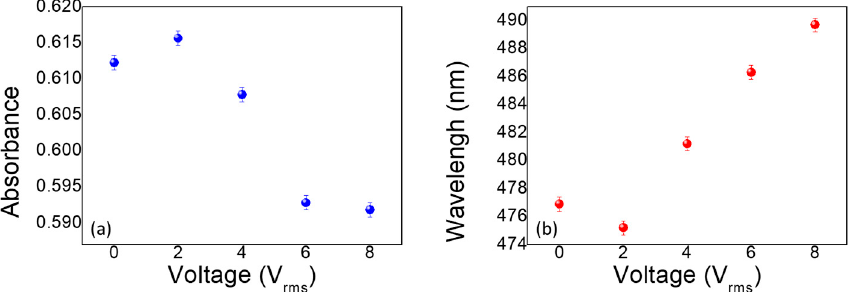
Figure 5. Absorbance and peak wavelength of the liquid crystal (LC)/gold nanoisland film (Au NIF) with various applied voltages of amplitudes 0~8 V rms .